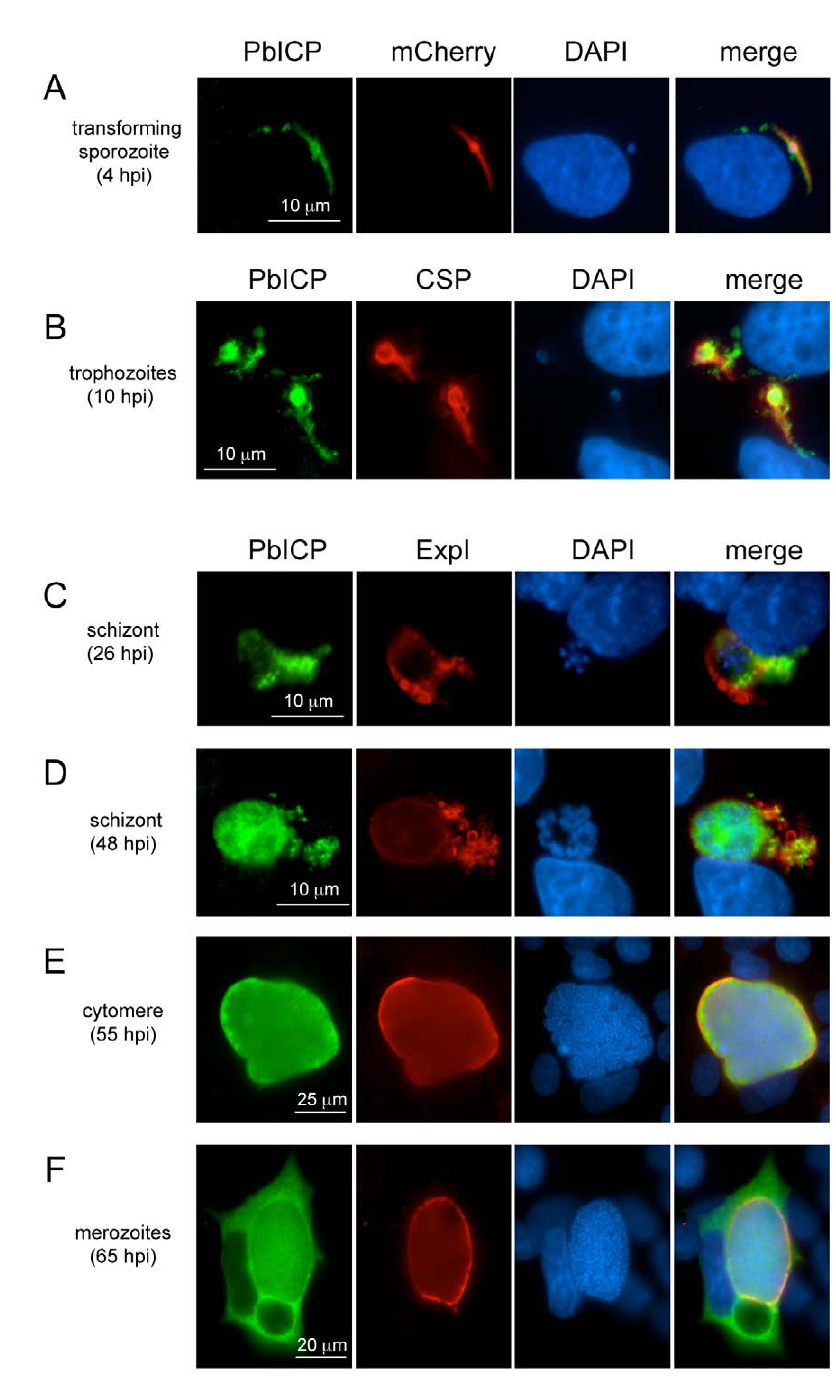
Figure 4. PbICP is expressed throughout the liver stage and localizes to different microenvironments. Wide-field IFA of HepG2 cells infected with P. berghei -expressing mCherry in the cytoplasm ( A ) or wildtype P. berghei ( B-F ) at different time points after infection (hpi, hours post infection). Infected cells were fixed, incubated with anti-CSP antiserum (mouse, red) ( B ) or with anti-ExpI antiserum (chicken, red) ( C-F ) and antiserum against PbICP-C (rabbit, green) ( A-F ). DNA was stained with DAPI